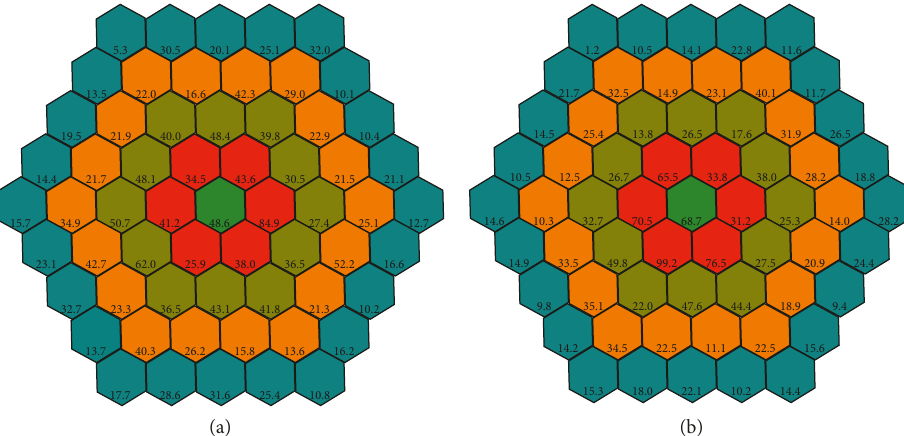
Figure 2: Amplitude of P1 nV/deg 2 in patient no. 4 in five rings centered in fovea, before surgery (a) and after surgery (b) Ring 1 (green) and ring 2 (red) are considered for study.